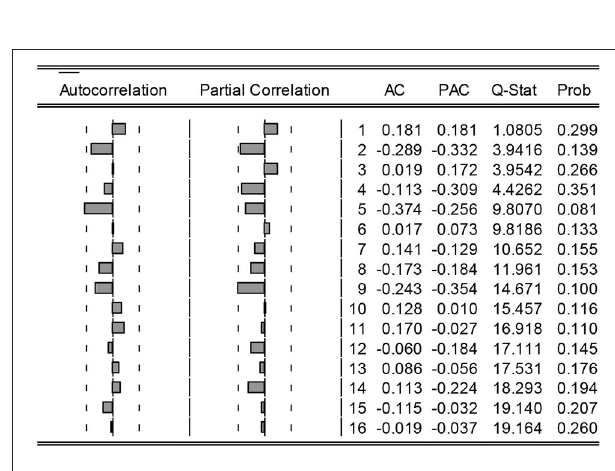
FIGURE 4 | Autocorrelation and partial autocorrelation graph.